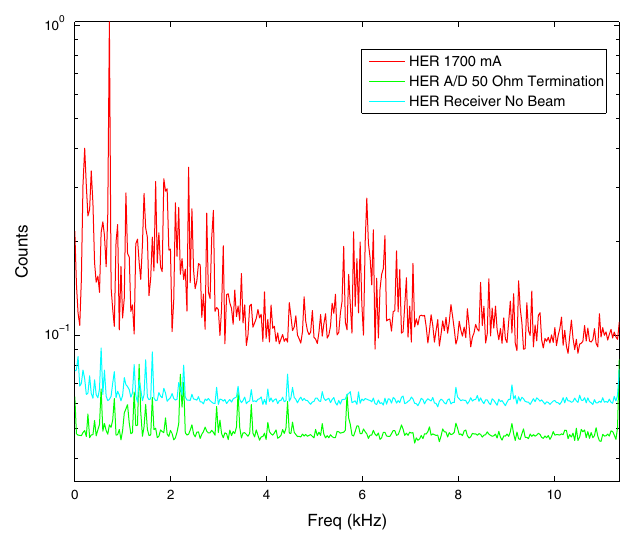
FIG. 6. (Color) Power spectrum of detected closed-loop HER beam motion (rms A/D Counts). A/D quantizing noise is 0.4 counts rms and the combined noise with the phase detector receiver (no beam) is 0.6 counts rms. It is important to realize that the quantization noise from the 8 bit A/D is negligible compared to the signals on the beam, and a 6 bit A/D system would suffice with the same performance.